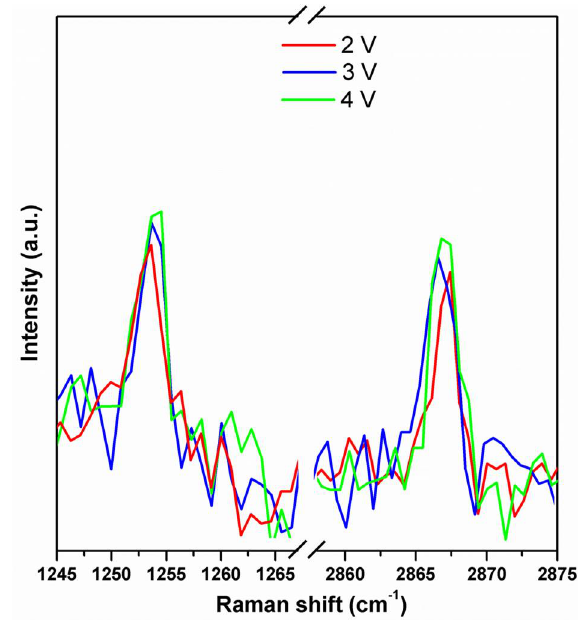
Figure 9. Onset of changed Raman spectra regions of CP36 in 0.1 M HCl during the transport experiment at 2 V, 3 V and 4 V.